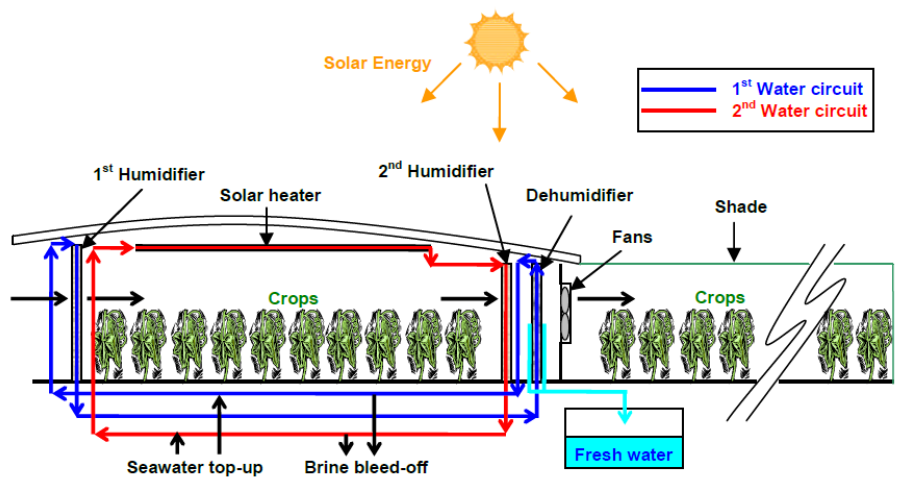
Figure 22. Illustration of the two water circuits of the HD GH in Oman [332].